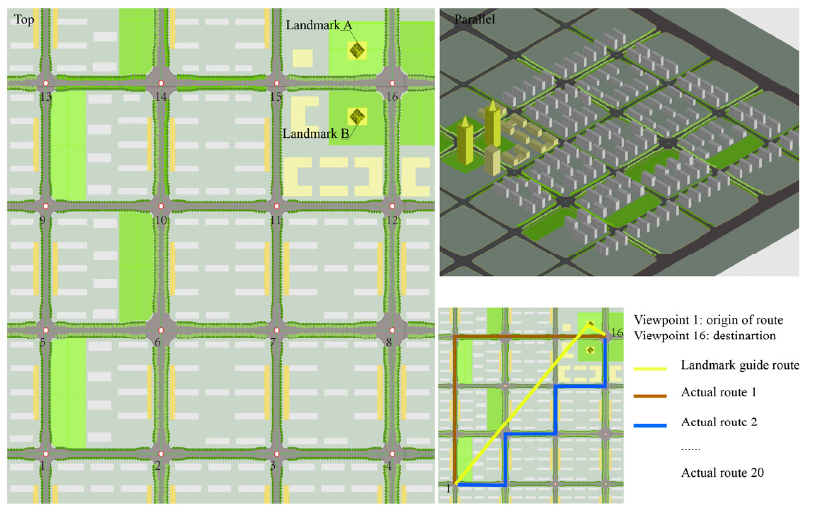
Figure 3. Simulated 3D geometric model of a standard urban residential neighborhood.